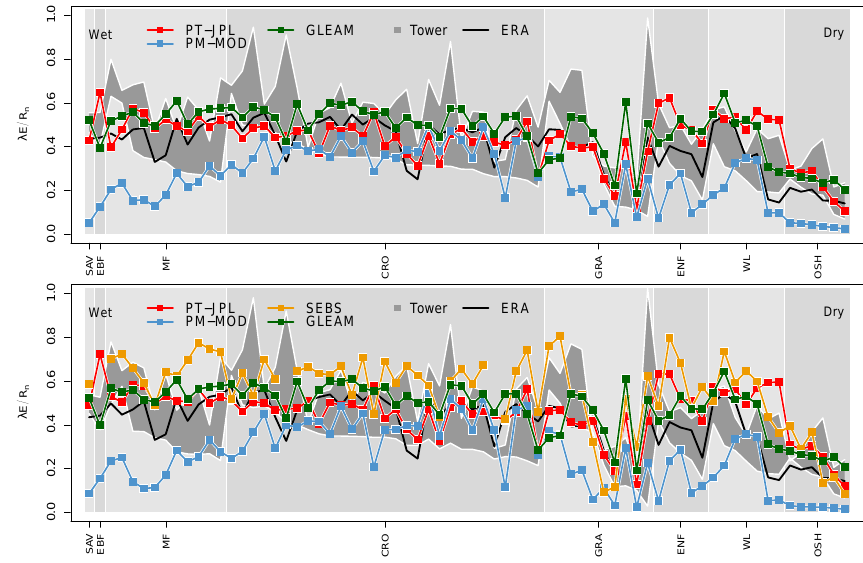
Figure 7. Top panel: station means of 3-hourly sinusoidal gridded satellite-forced evaporative fraction for full days (70 stations) against tower reference, as function of biomes, sorted from wet to dry (based on the biome average). Bottom panel: same as top panel but for midmorning only (from 09:00 to 13:00LT; 67 stations). The grey area denotes the range of evaporative fraction between EC and ER measurements. The black line denotes EF derived from ERA-Interim ET and R n .